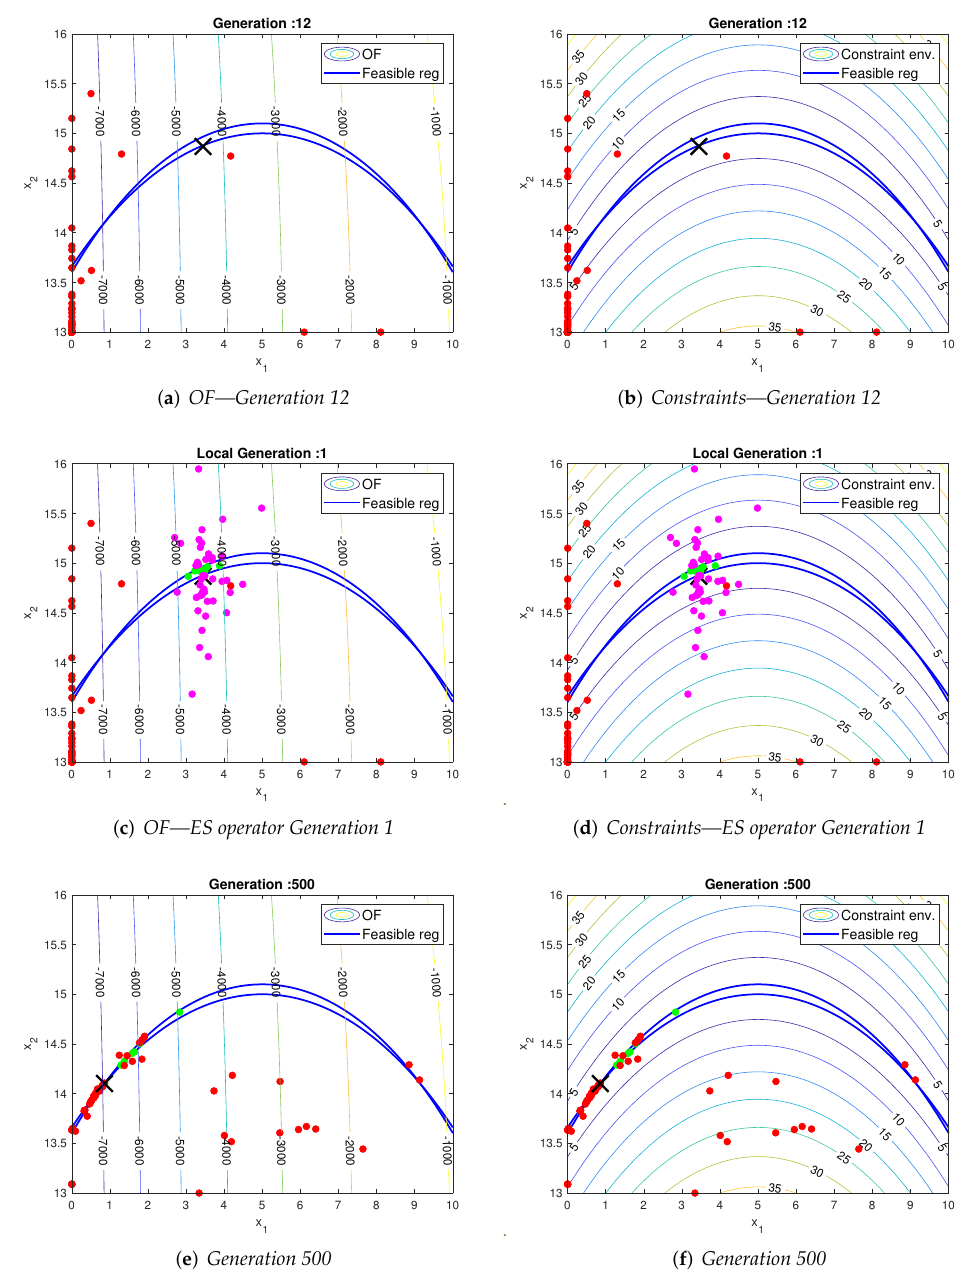
Figure 4. Example Problem g06, see the Appendix A (Sickle Problem [52]); ( a , b ) the OF and constraints envelope contour representations, respectively at generation 12. The black cross marker is the unfeasible gbest, the red dots are the swarm points. ( c , d ) After 10 unfeasible stagnations, the ES local search operator generate a local search population (purple dots) to find the feasible region (green dots). ( e , f ) the OF and constraints envelope contour representations, respectively, at the final generation 500. The black cross marker is the feasible gbest point, the red ones are the particles in a unfeasible region, and the green ones are the particle inside the feasible